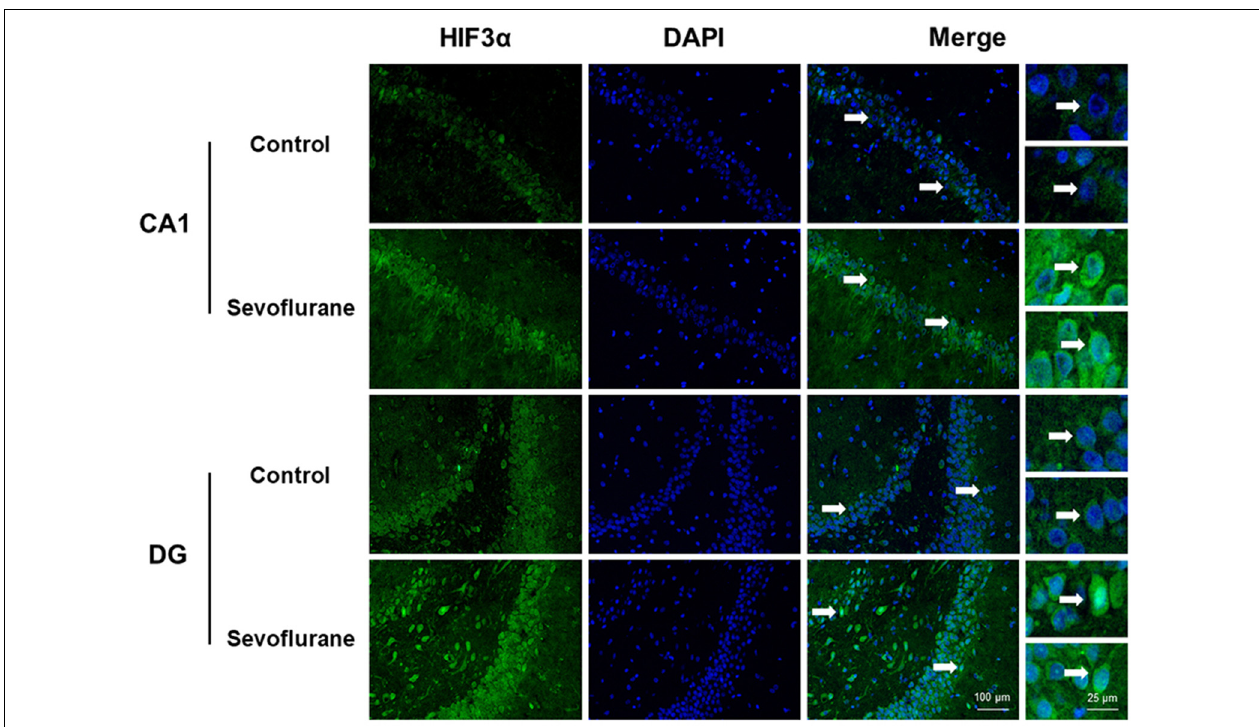
FIGURE 5 | Immunofluorescent staining of hippocampal hif3a in the CA1 region and DG region. Immunofluorescence images show RelA (FITC, green) and DAPI (blue) counterstain. In the control condition, RelA was primarily distributed in the cytosol of the pyramidal cell layer, CA1 region and the cytosol of the granular cell layer, DG region. Six hours after exposure, RelA was distributed in both nucleus and cytosol. Arrows point to the typical RelA distribution, which are provided as high magnification images. Magnification 400 × , scale bar 100 and 25 µ